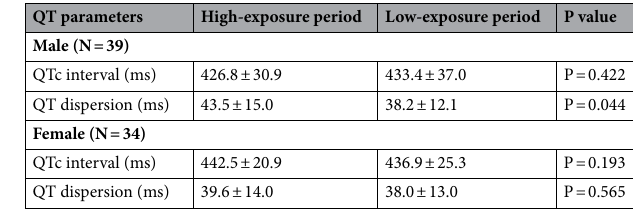
Table 3. Differences in corrected QT interval and QT dispersion during the PM2.5 high-exposure and the low-exposure period. QTc corrected QT interval.